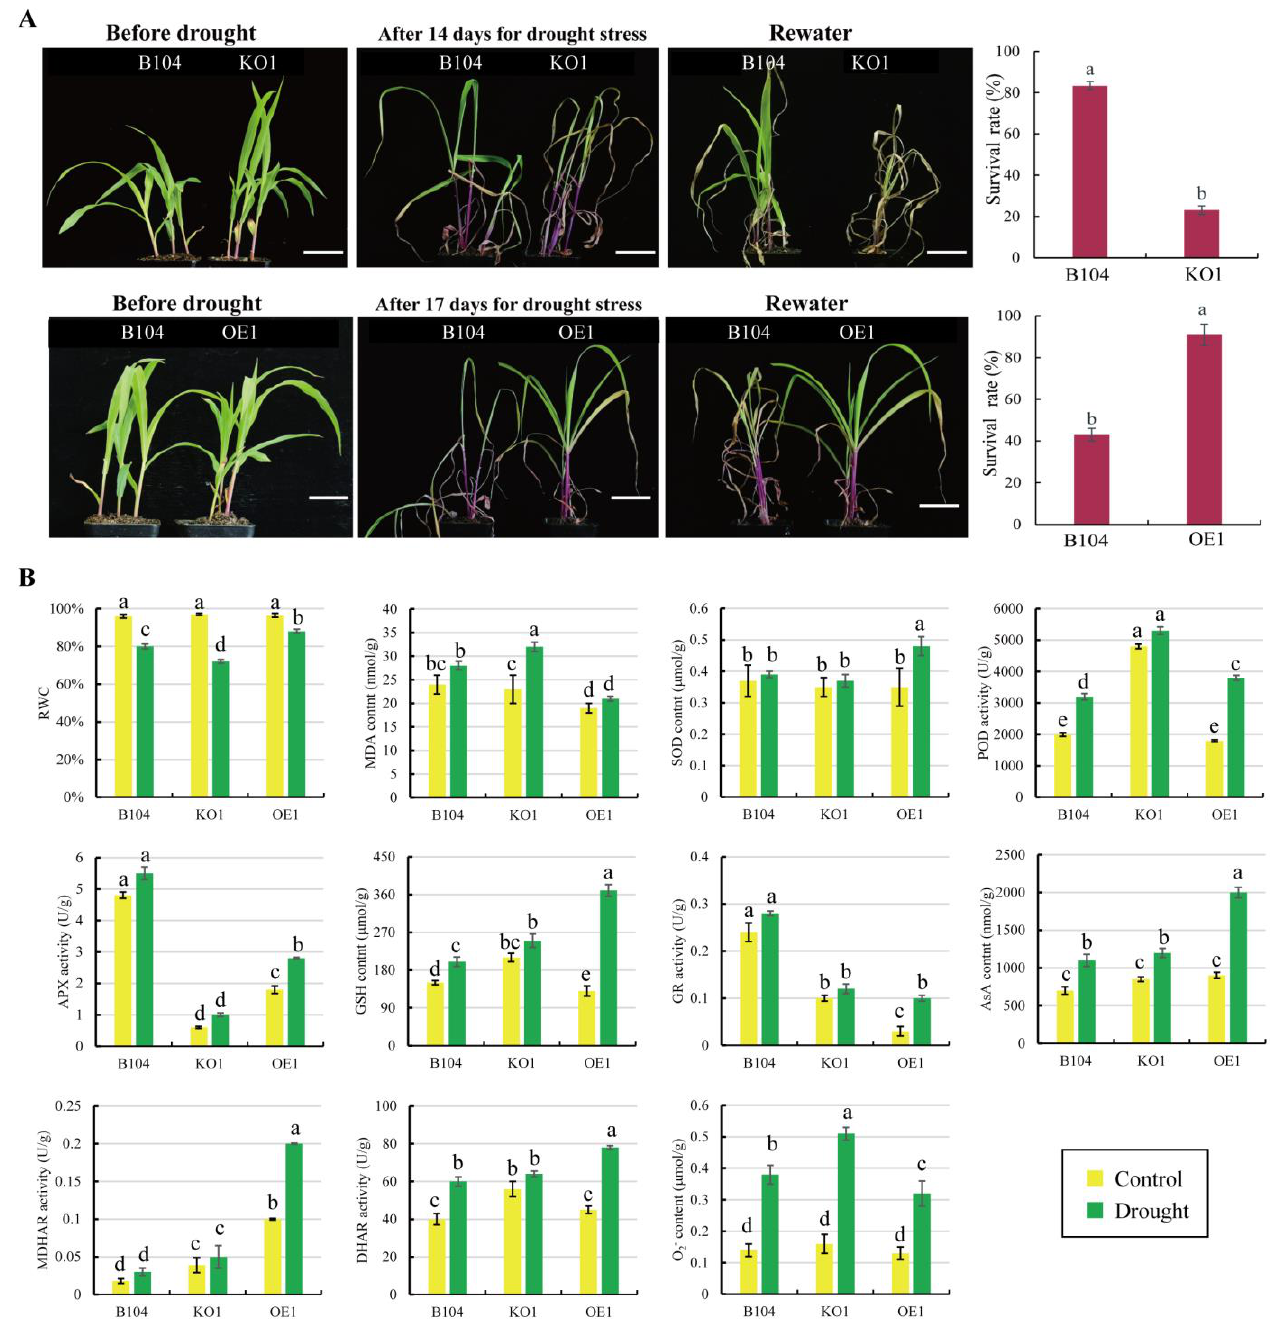
Figure 8. WT, KO and OE seedlings were examined for resistance to drought stress. ( A ) Phenotypes of seedlings under normal watering (control), drought and drought/rehydration conditions. Scale bar: 10 cm. ( B ) Physiological indexes of WT, KO1 and OE1 seedlings under drought conditions. RWC, relative water content; MDA, malondialdehyde; SOD, superoxide dismutase; POD, peroxidase; APX, ascorbate peroxidase; GSH, glutathione; GR, glutathione reductase; AsA, ascorbic acid; MDHAR, monodehydroascorbate reductase; DHAR, dehydroascorbate reductase; O 2− , superoxide anion. Data represent means ± SD of three biological replicates. Significant differences are indicated with different letters ( p < 0.05, two-way